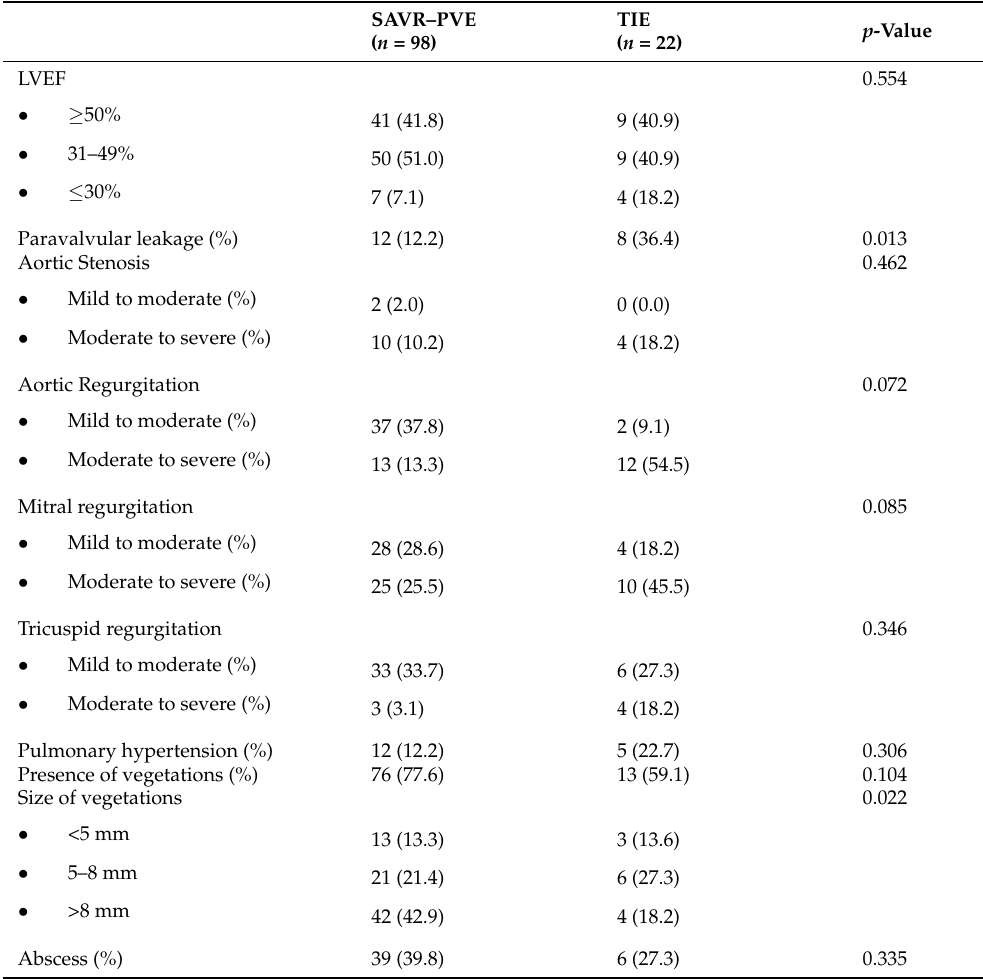
Table 3. Preoperative echocardiographic data. LVEF, left ventricular ejection